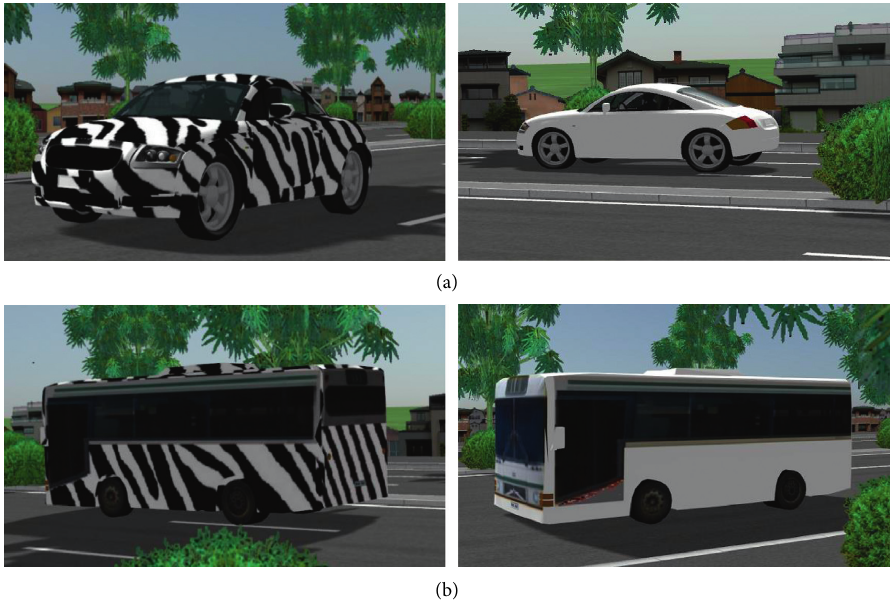
Figure 3: Vehicle models. (a) Car models. (b) Bus models.